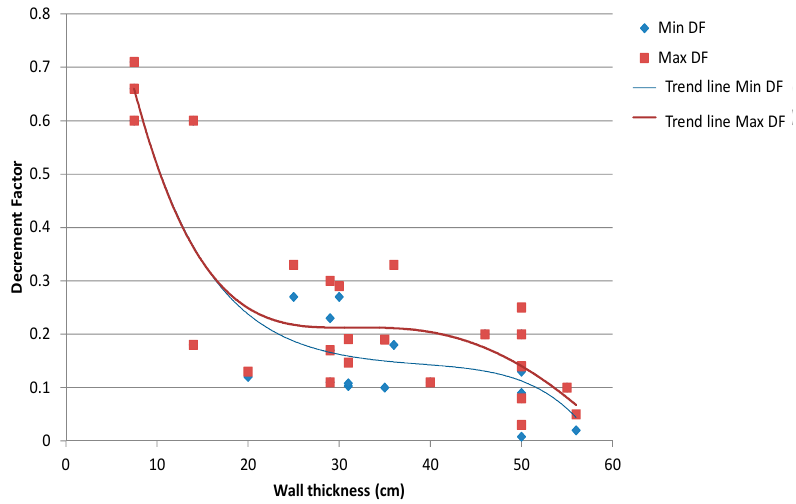
decrement factor for earth wall between 10 − 20 cm thick. From 20 to 50 cm the decrement factor is stabilized in a range of 0.13–0.21. Figure 4. Relation between the wall thickness and its thermal transmittance, according to each climate.